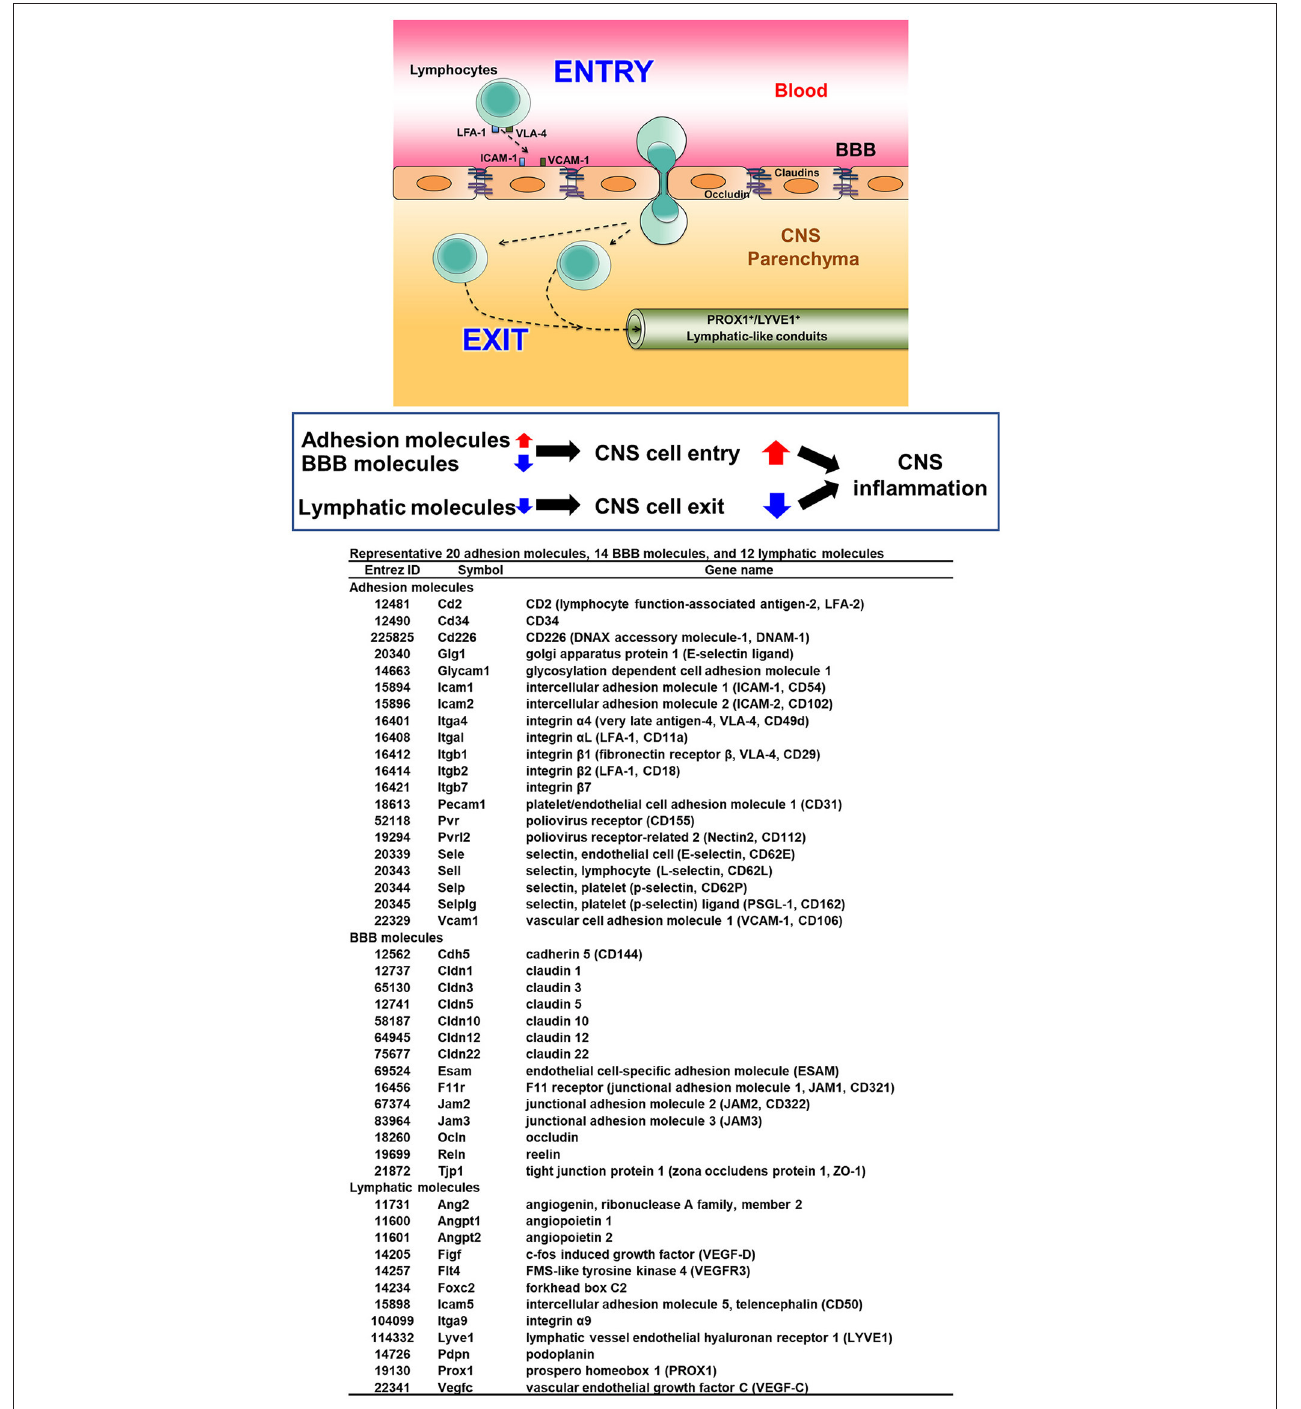
FIGURE 5 | Three components of lymphocyte entry into and exit from the CNS (61, 62). To initiate inflammation in the CNS, lymphocytes interact with endothelial cells of blood vessels via up-regulated adhesion molecules, particularly very late antigen (VLA)-4 and lymphocyte function-associated antigen (LFA)-1 on lymphocytes with vascular cell adhesion molecule (VCAM)-1 and intercellular adhesion molecule (ICAM)-1 on endothelia, respectively. Downregulation of molecules composed of the blood-brain barrier (BBB) also help in lymphocyte entry into the CNS parenchyma. While the precise mechanism of lymphocyte exit from the CNS is unknown, one hypothesis is the presence of vessels similar to peripheral lymphatic vessels, whose markers include prospero homeobox (PROX) 1 and lymphatic vessel endothelial hyaluronan receptor (LYVE) 1, may help in lymphocyte exit from the CNS to deep cervical lymph nodes. Increased lymphocyte entry together with decreased lymphocyte exit could lead to enhancement of CNS